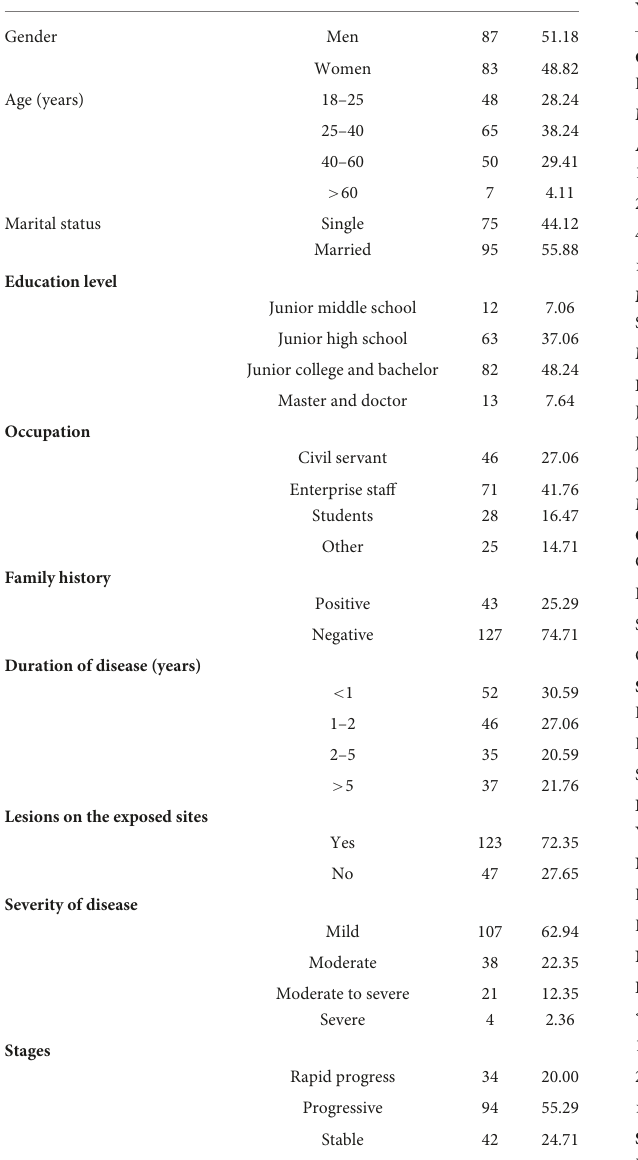
TABLE 1 Basic data of patients with vitiligo. Characteristics